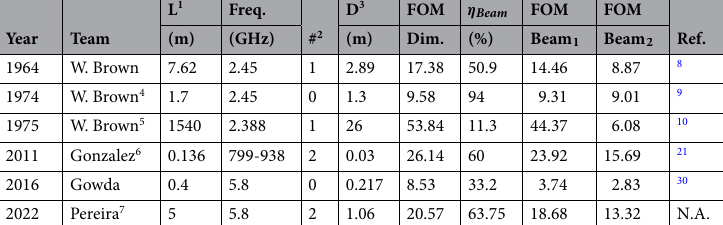
Table 1. Wireless power transfer state-of-the-art. The beam efficiency is as defined in Eq. (5), including all the components except the microwave generation, rectification and the cable losses. Finally, the figures of merits (FOM) are described in Eqs. (1), (2), and (3). 1 Power transfer distance. 2 Number of focusing components. 3 Largest component dimension. 4 Highest DC-DC efficiency. 5 Highest outputted DC power. 6 WPT in the Fresnel zone. 7 This work, quasioptical